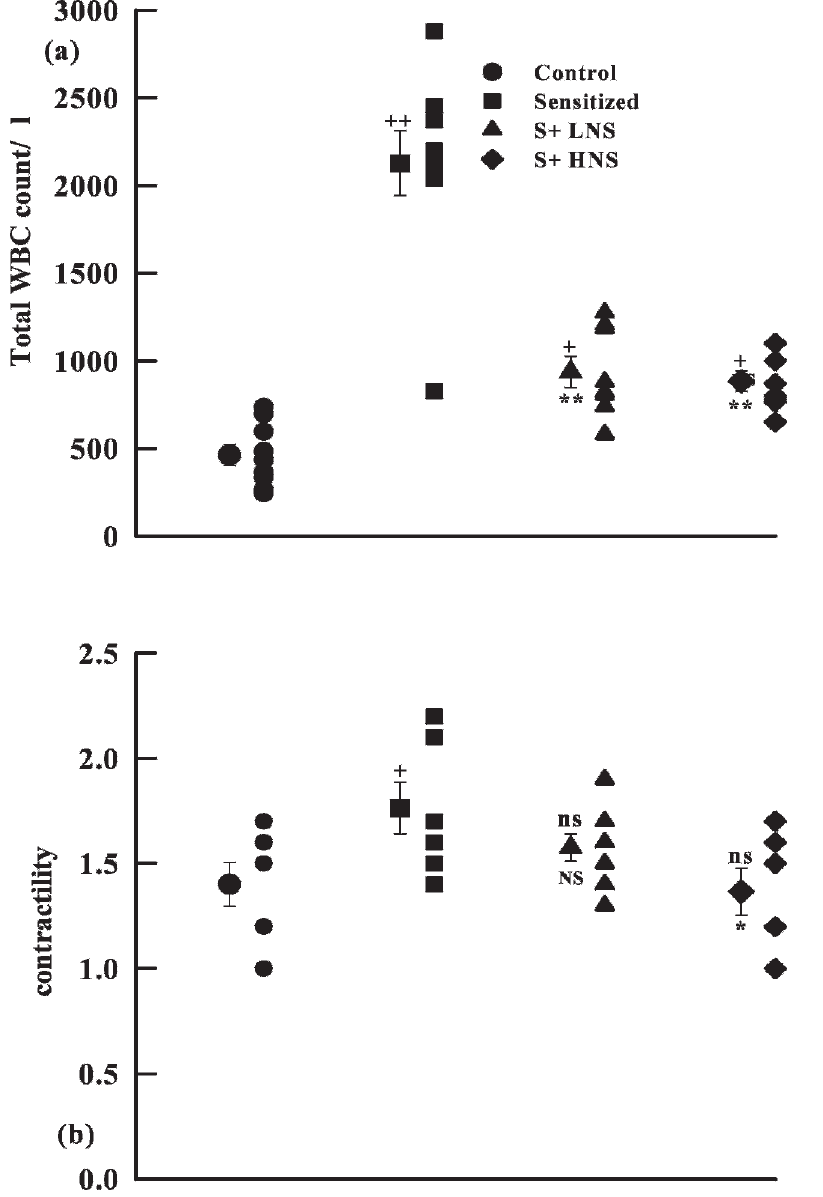
Figure 5 - Individual values and the mean ¡ SEM (larger symbols with bars) of the total WBC count (a) and tracheal contractility response to 10 m M methacholine (b; for each group, n =7). Statistical differences between the control and different groups: ns; non- significant difference, + ; p , 0.05. Statistical differences between the S + LNS and S + HNS vs. sensitized group: NS; non-significant difference, *: p , 0.05, **: p , 0.01. There was no significant difference in the effects of the two different concentrations of